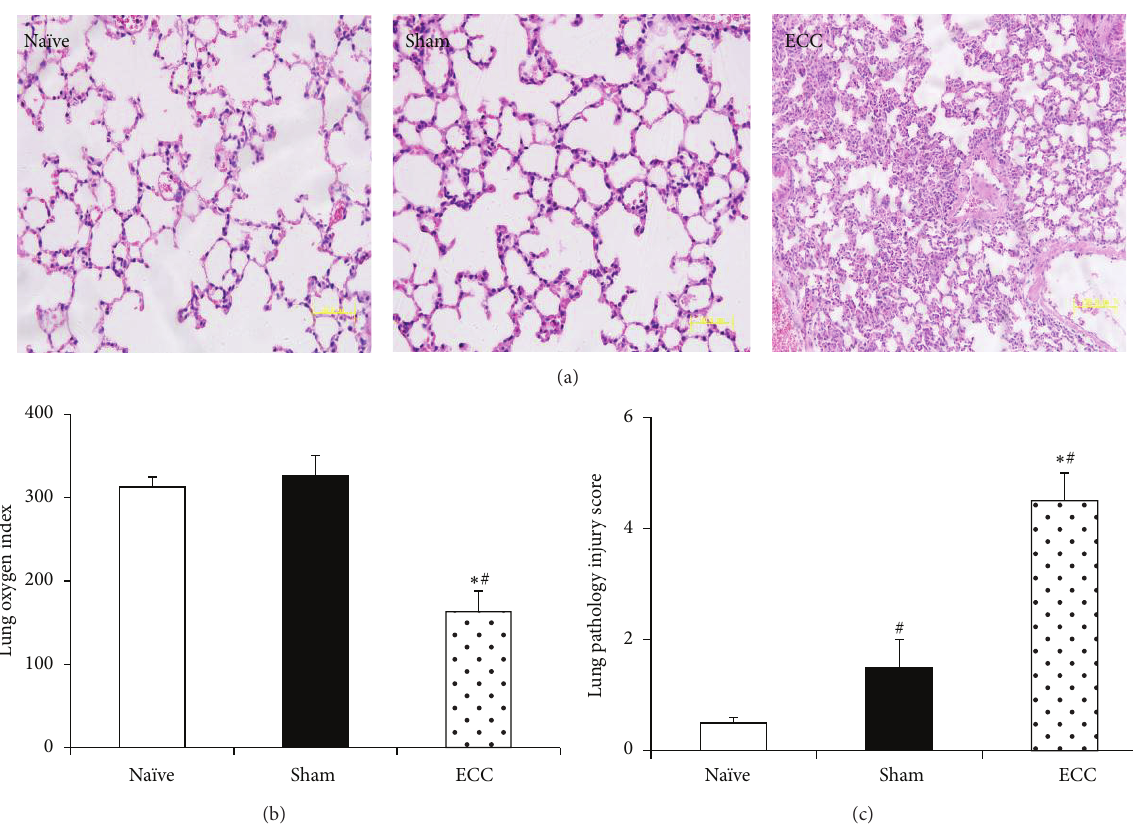
Figure 4: Lung function and tissue morphology after ECC. Mice were treated as described in Figure 2, and lung histopathology and arterial blood gas analysis were performed at 60min after the end of ECC. (a) The upper lobe of the left lung was fixed in formaldehyde, sectioned, and stained with hematoxylin and eosin ( 𝑛 = 10 ; magnification, 40x). (b) The oxygenation index was calculated as FiO 2 /PaO 2 . (c) Acute lung injury was scored as described in Section 2. ∗ 𝑃 < 0.05 versus Sham, # 𝑃 < 0.05 versus